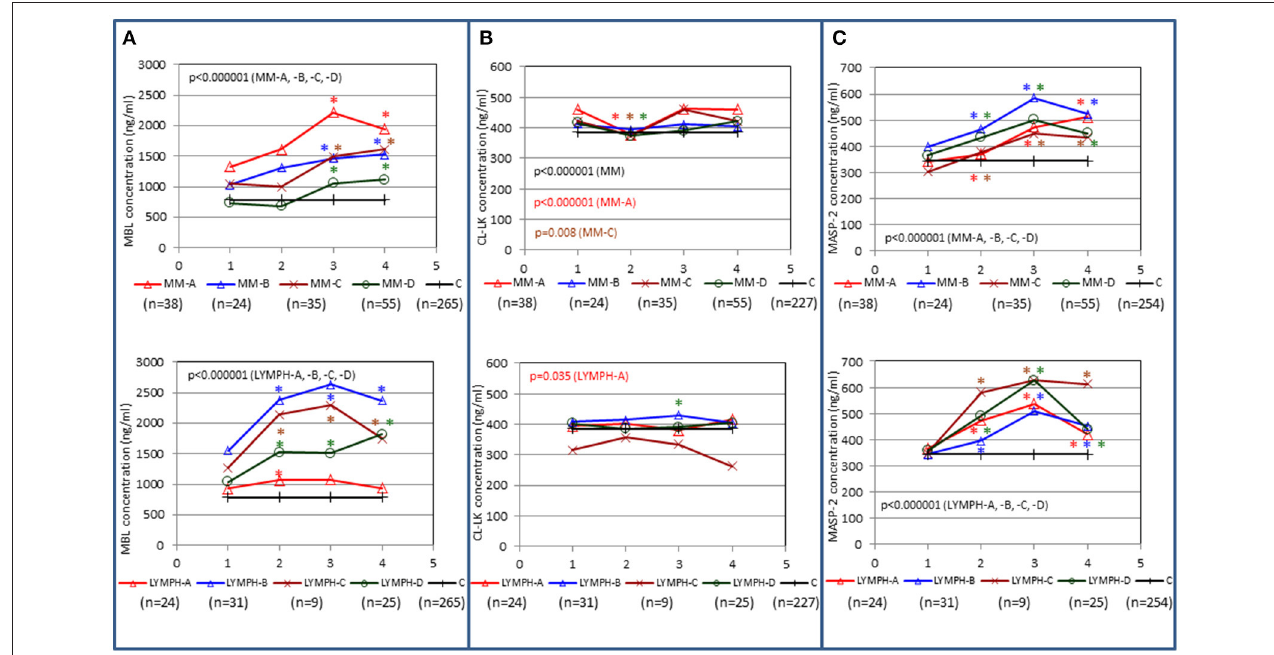
FIGURE 3 | Changes in concentrations of MBL (A) , CL-LK (B), and MASP-2 (C) in patients, during treatment. 1–blood taken directly before conditioning chemotherapy; 2 – blood taken directly before autologous hematopoietic stem cell transplantation; 3–blood taken 1 week after HSCT; 4—blood taken 2 weeks after HSCT. Data from sample 5 (3 weeks after HSCT) are not shown due to relatively low number of cases within each subgroup. Median values for each time-point are presented. MM-A, LYMPH-A: patients who experienced infections with proven bacteremia; MM-B, LYMPH-B: patients who experienced infections with no bacteremia; MM-C, LYMPH-C: patients who experienced febrile neutropenia; MM-D, LYMPH-D: patients who experienced none of afore-mentioned complications during hospital stay. C—controls (sampled once). Statistics: given p -values regard to Friedman’s ANOVA while asterisks (in colors corresponding to curves) mark significant differences in comparison with sample 1 (Wilcoxon’s paired sample test). Graphs show data from complete sets (MBL levels measured in all 1-4 samples) only. Numbers of patients are given in parentheses.